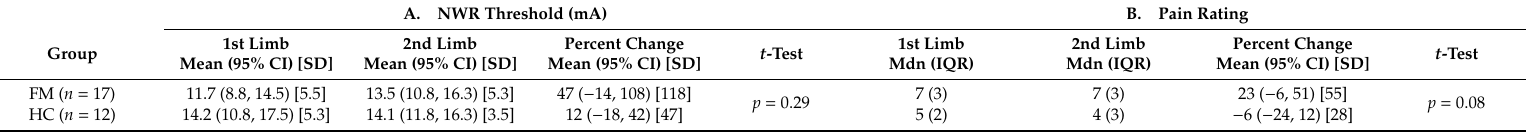
Table 3. NWR thresholds and subjective pain ratings, 1st and 2nd limb comparison.